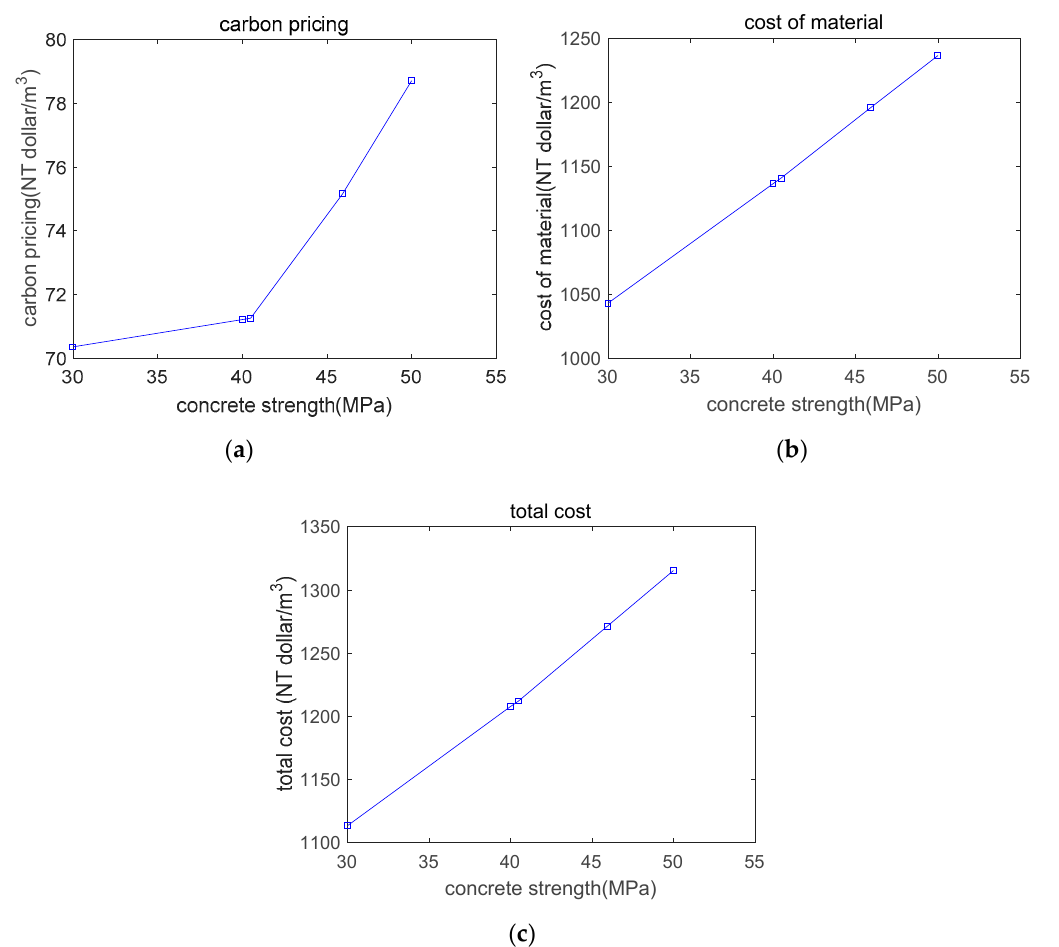
Figure 10. The cost of the concrete mixture. ( a ) carbon pricing; ( b ) cost of concrete material; ( c ) total cost of each mixture.